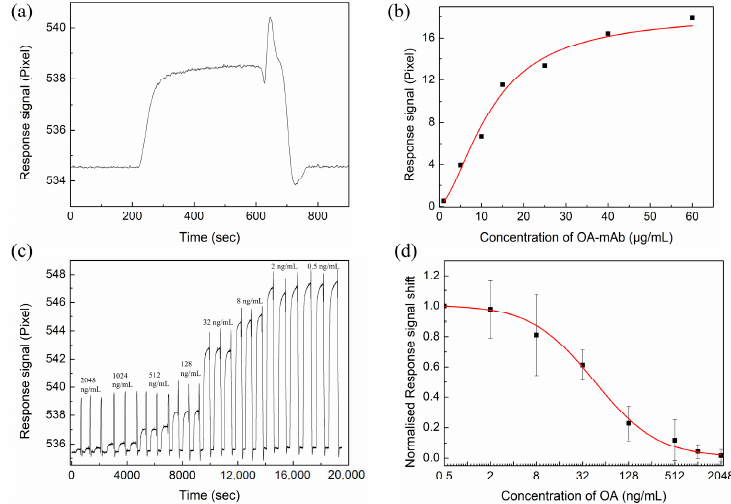
Figure 14. ( a ) The specific interaction process between OA-mAb (5 µ g/mL) and the OA-BSA followed by regeneration step. ( b ) The shift in response signal with increasing concentration of OA-mAb. ( c ) The SPR response signal curves of OA solution at different concentrations for the proposed SPR biosensor. ( d ) Calibration curve for the detection of OA by indirect competitive inhibition.